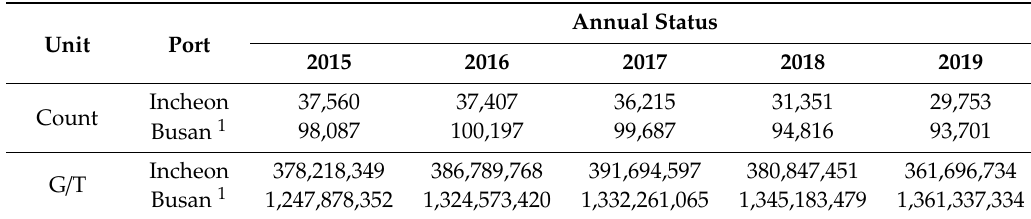
Figure 4. Geographical locations of the Busan and Incheon ports in the Korean peninsula. Table 4. Port status from 2015–2019 by count and gross tonnage.